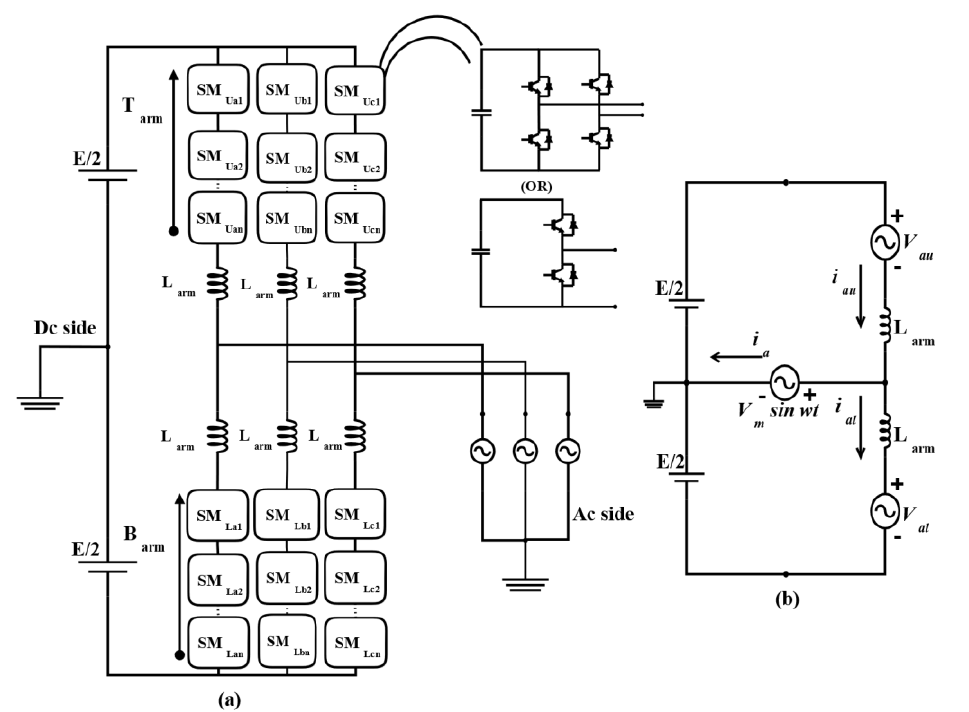
Figure 1. (a) Configuration of three-phase MMC, (b) single-phase equivalent circuit of conventional MMC.